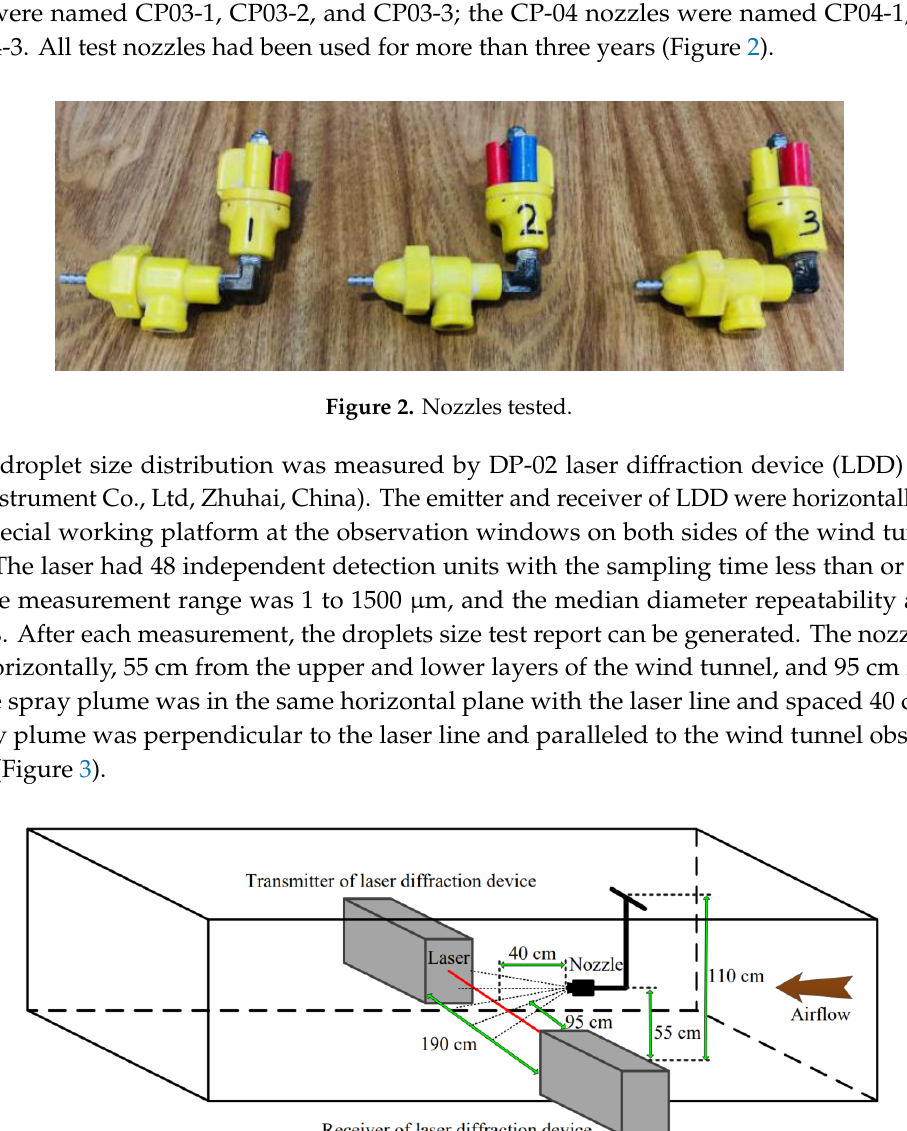
Figure 1. SCAU wind tunnel.